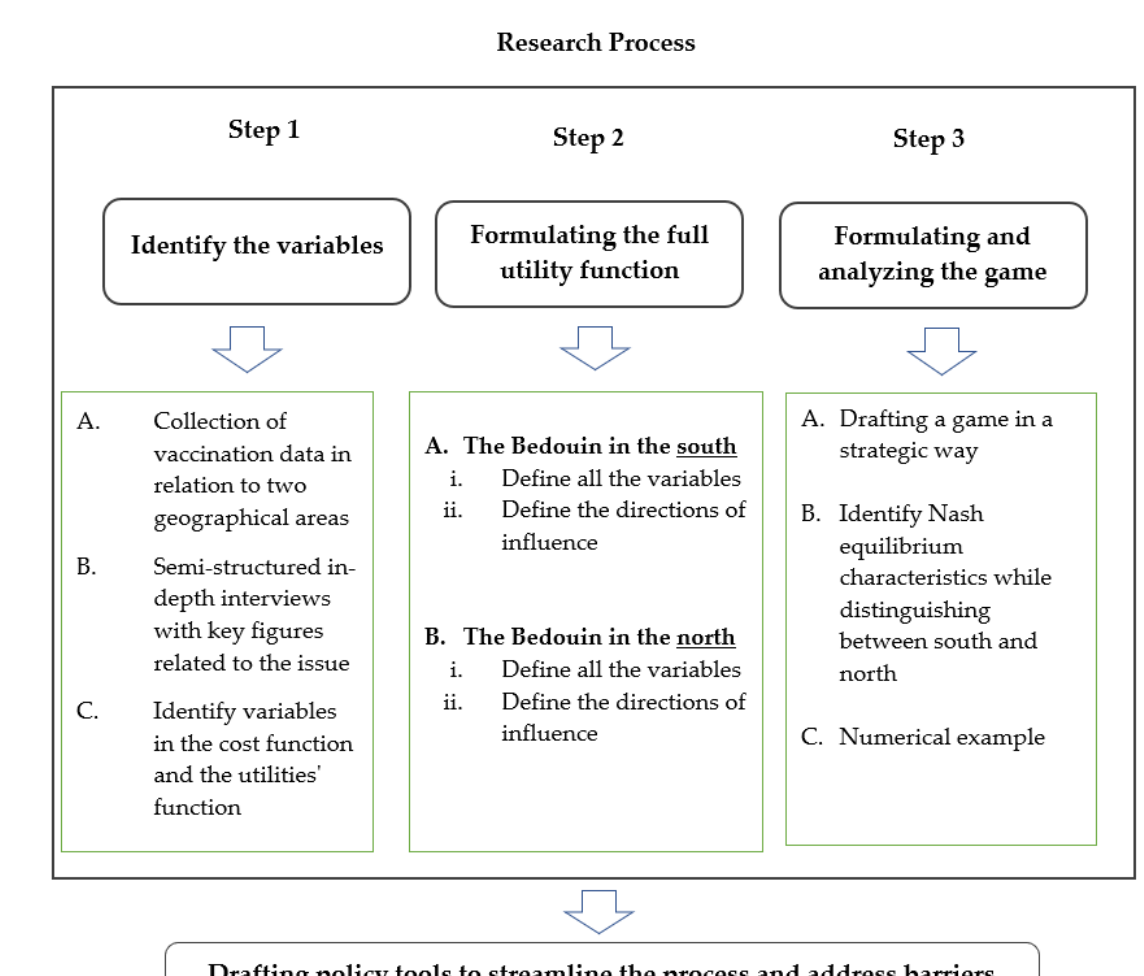
Figure 2. The research